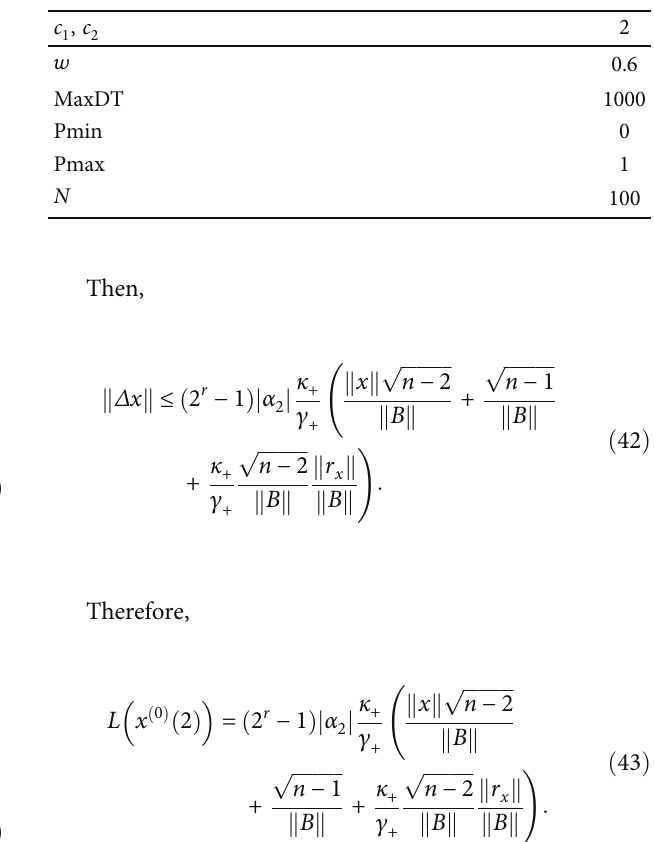
ffiffiffiffiffiffiffiffiffiffi p n − 2